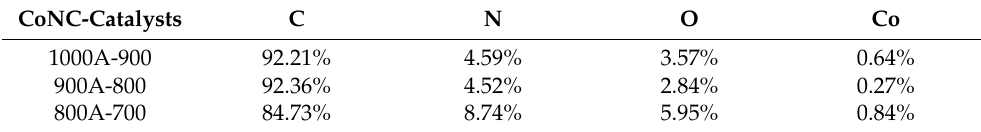
Figure 2. X-ray diffraction patterns of various Co-N-Cs treated with ( a ) one-stage ( b ) two-stage calcinations. Table 2. Atomic ratios (%) of various Co-N-C catalysts, as determined from EDS spectra.